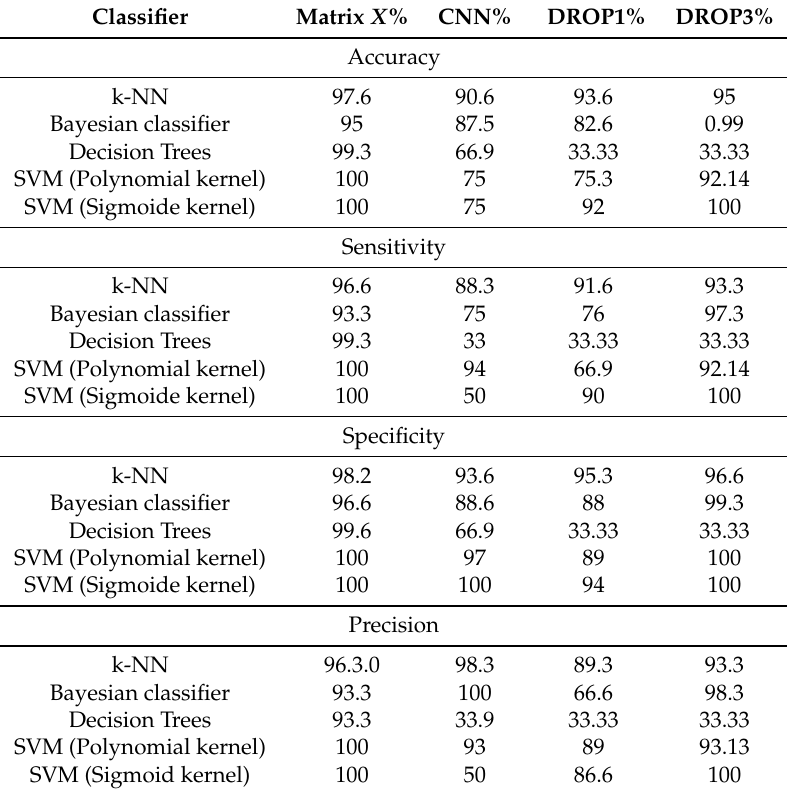
Table 3. Classifier’s